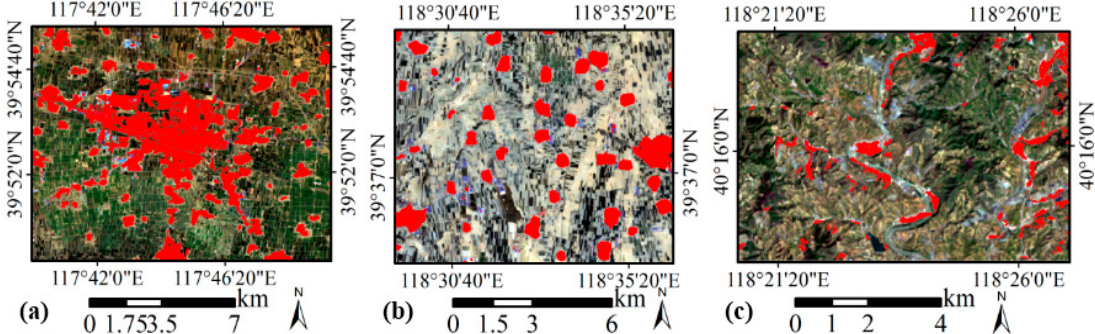
Figure 9. The extraction results of NDSTI-Red in typical areas of the experimental study area. (a), (b), (c) represent C, D, E typical area respectively.